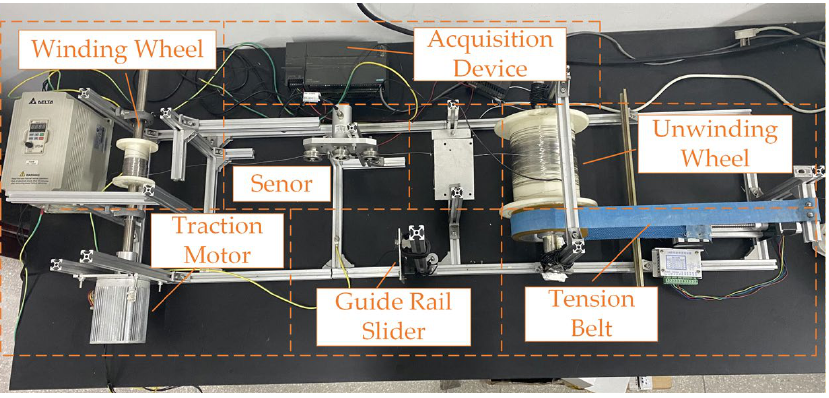
Figure 6. Simulation and experimental apparatus for strand movement.